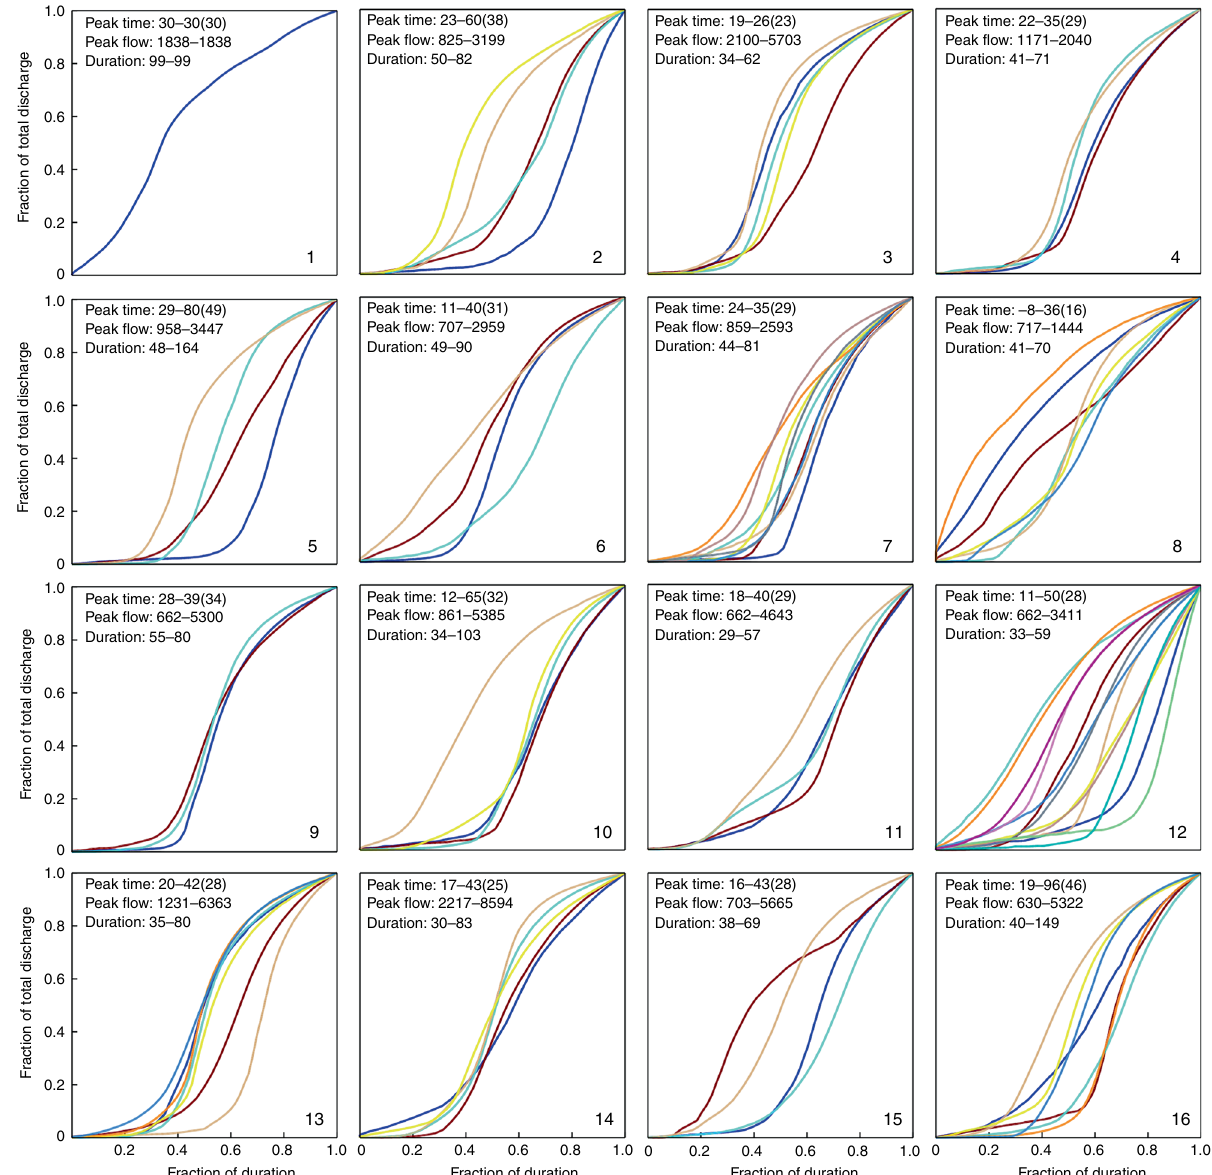
Fig. 4 Normalized fl ow characteristic curves using the fi rst typhoon duration scheme. The fi rst scheme determining typhoon duration spans between the arrival and departure time of a typhoon over the gridded zone. A normalized fl ow characteristic curve plots the fraction of total discharge against the fraction of duration. Different colors are shown for each typhoon